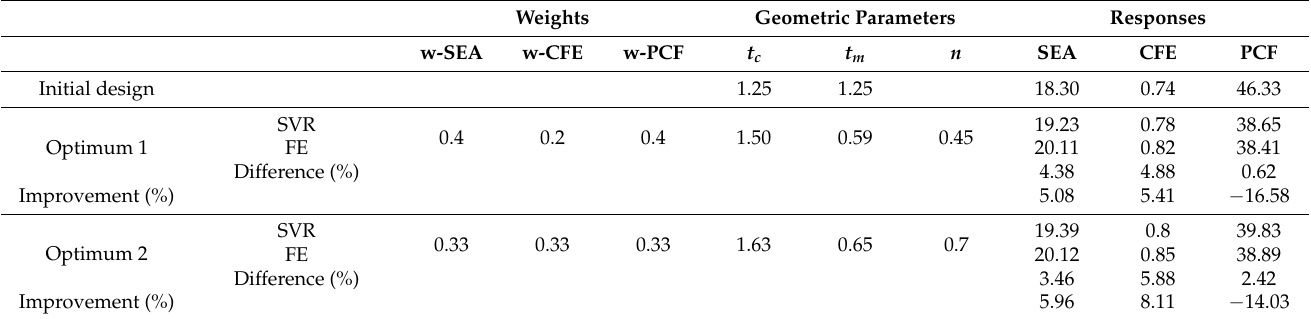
Figure 13. Most of the samples lie in the region t c > t m , and are basically distributed on